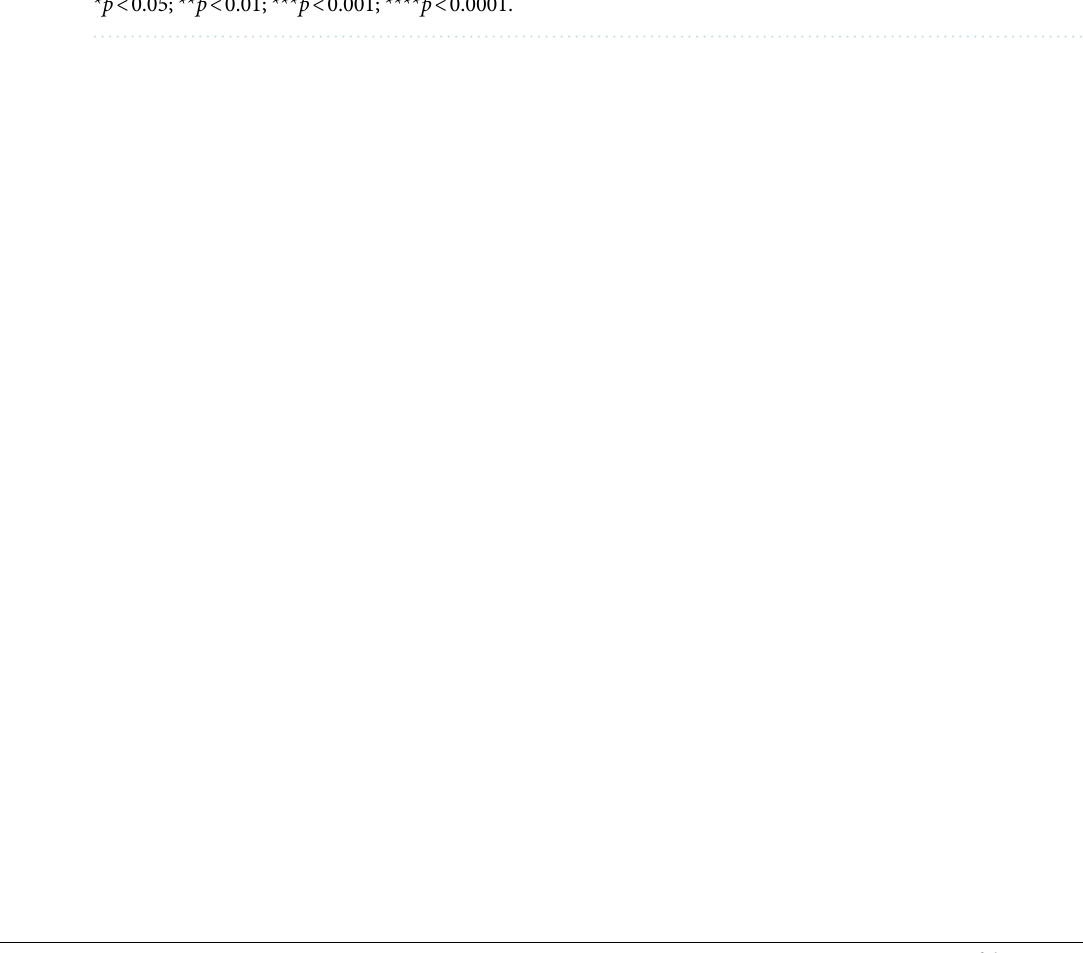
Figure 9. Increased metabolic dysfunction in ageing mice and their prevention by treatment with R–Cu. ( A – C ) represent histograms of levels of serum glucose, cholesterol and CRP, respectively. Bars represent mean ± SEM values. N = 4 animals in each group of both sexes except in cholesterol female young control (N = 3) and cholesterol male young control (N = 2). Levels in young controls and R–Cu treated ageing animals were compared with those of ageing controls, and statistical analysis was performed by two-tailed Student’s t test. * p < 0.05; ** p < 0.01; *** p < 0.001; **** p <